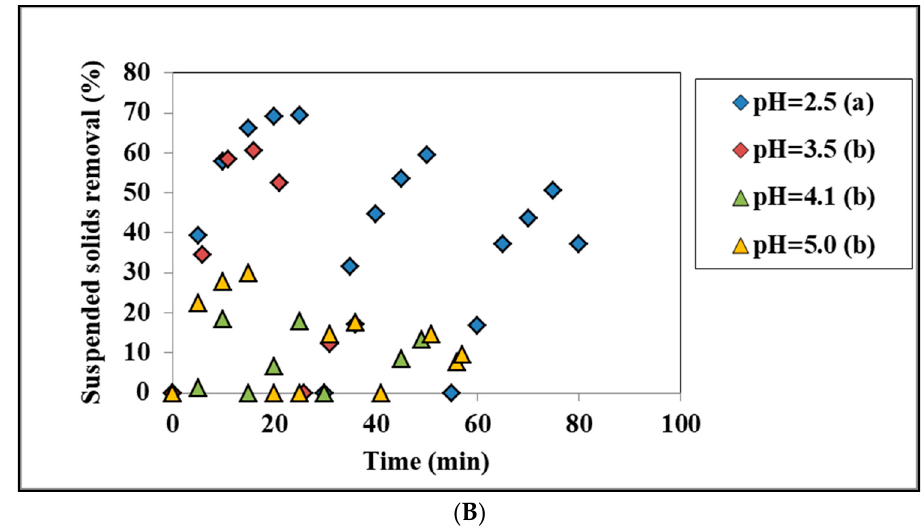
Figure 6. ( A ) pH influence on color removal (a) 17 L/h, 100 rpm; (b) 20 L/h, 200 rpm. Initial operating conditions: C 0,H2O2 = 14.91 mM; C 0,Fe2+ = 0.10 mM FeSO 4 . ( B ) pH influence on suspended solids removal (a) 17 L/h, 100 rpm; (b) 20 L/h, 200 rpm. Initial operating conditions: C 0,H2O2 = 14.91 mM; C 0,Fe2+ = 0.10 mM FeSO 4 .